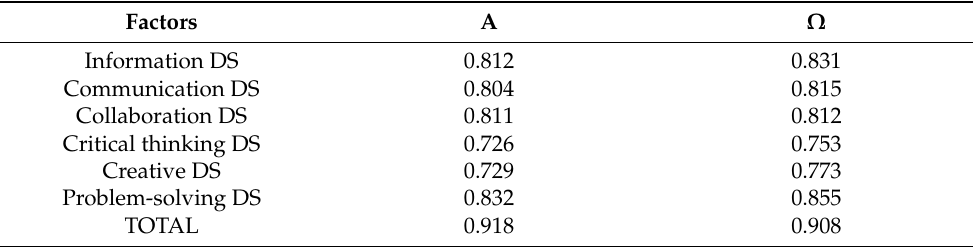
Table 3. Reliability coefficients.